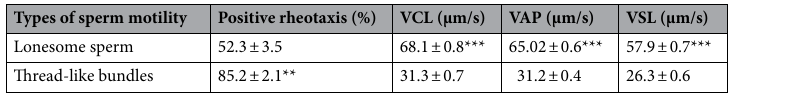
Table 2. The swimming velocity and the percentage of sperm showing positive rheotaxis in lonesome sperm and thread-like bundles. curvilinear VCL, straight-line VSL, and average path velocity VAP. (means ± SD) was used to express all measurements. *Significant at (P ≤ 0.05); **Significant at (P ≤ 0.01); ***Significant at (P ≤